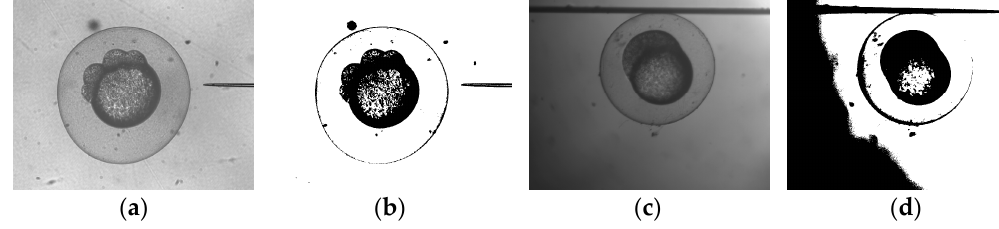
Figure 7. Results of conventional threshold: even illumination ( left ); uneven illumination ( right ). ( a ) Original image (even illumination); ( b ) Binary image with Otsu’s method (even illumination); ( c ) Original image (uneven illumination); ( d ) Binary image with Otsu’s method (uneven illumination).